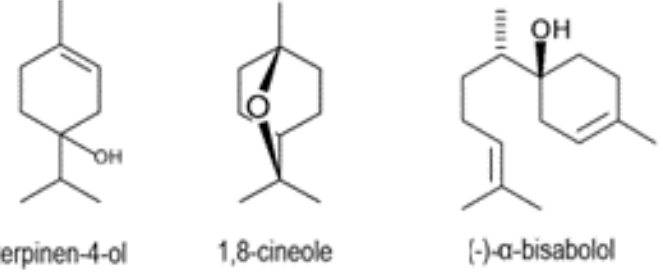
Figure 6. Chemical structures of the major phytoconstituents identified in the plant-based substance via GC/MS analysis.